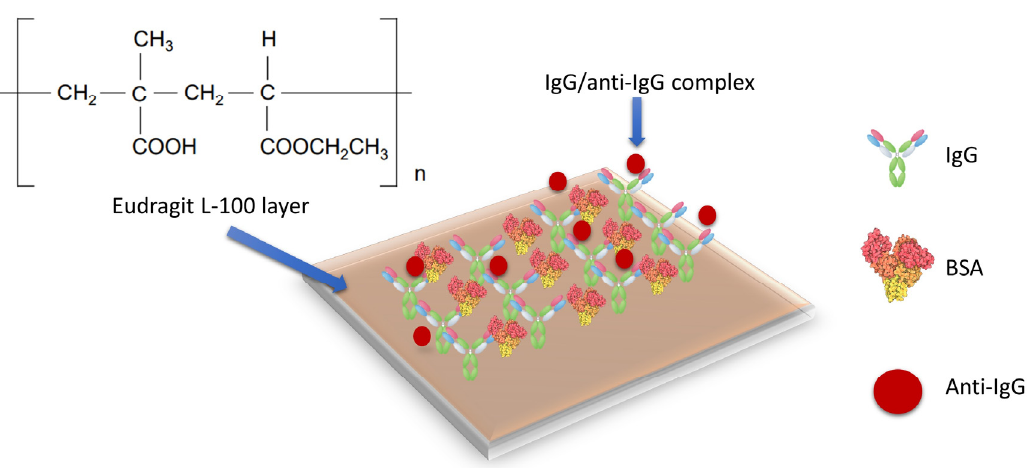
Figure 5. Sketch of the sensor functionalization and analyte detection.